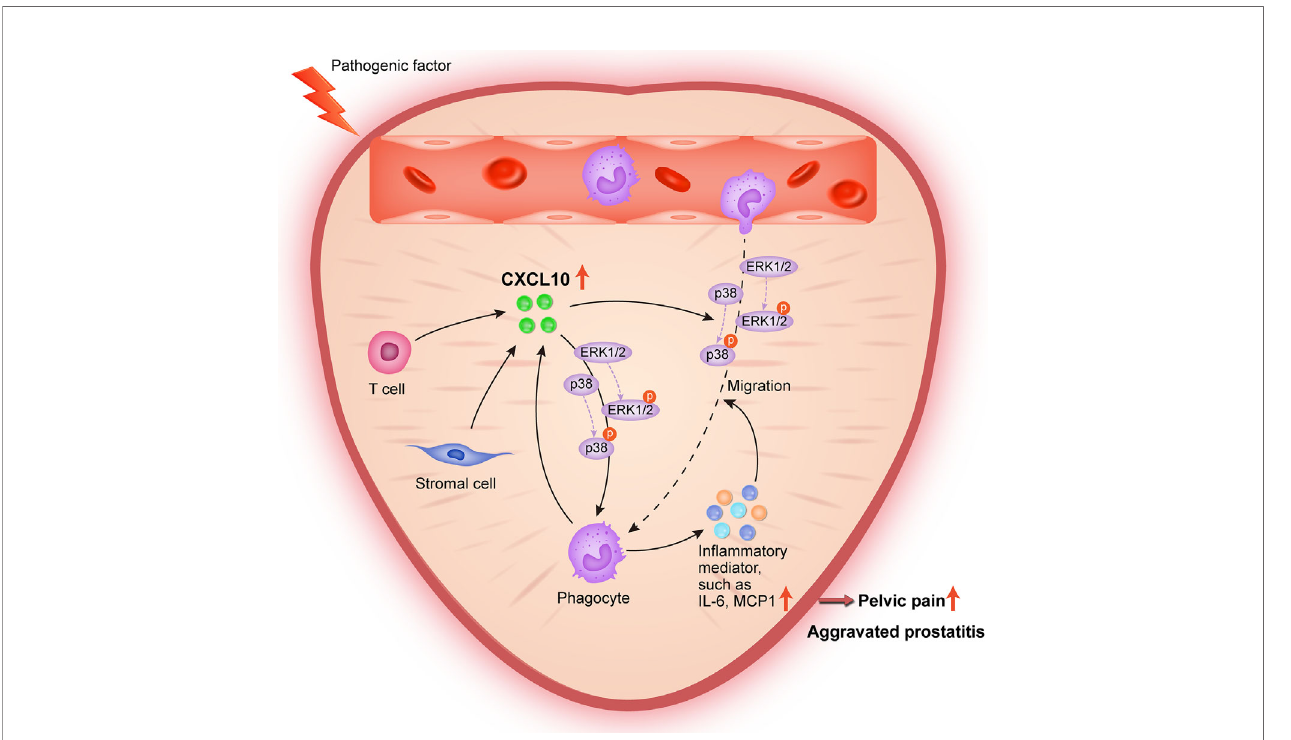
FIGURE 8 | Schematic diagram of the pathogenic roles of CXCL10 in EAP. During EAP, CXCL10 recruits macrophages to prostate and induces the secretions of proin fl ammatory mediators via the Erk1/2 and p38 MAPK signaling pathways, leading to the exacerbation of EAP. Prostatic stromal cells, T cells, and macrophages are potential sources of